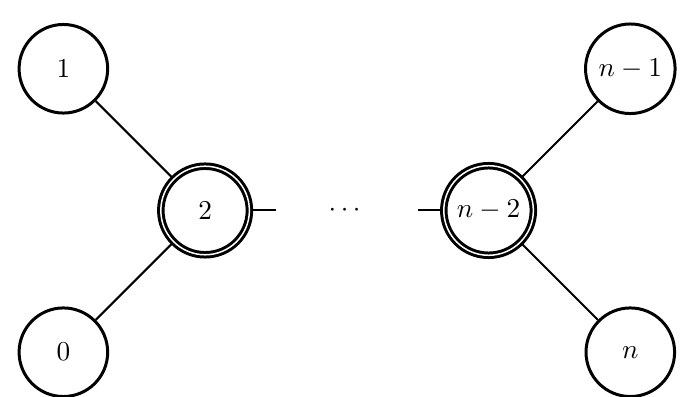
Figure 3. Dynkin diagram for so (2 n ) . The numbers give the value of I corresponding to each node, with the affine node having I = 0 . Nodes marked with two concentric circles occur with multiplicity 2 in the fiber.